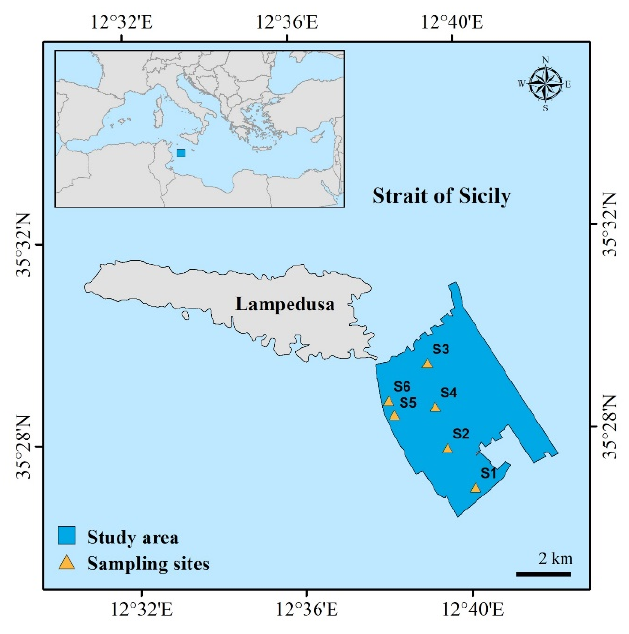
Figure 1. Map of Lampedusa study area with indication of sampling sites